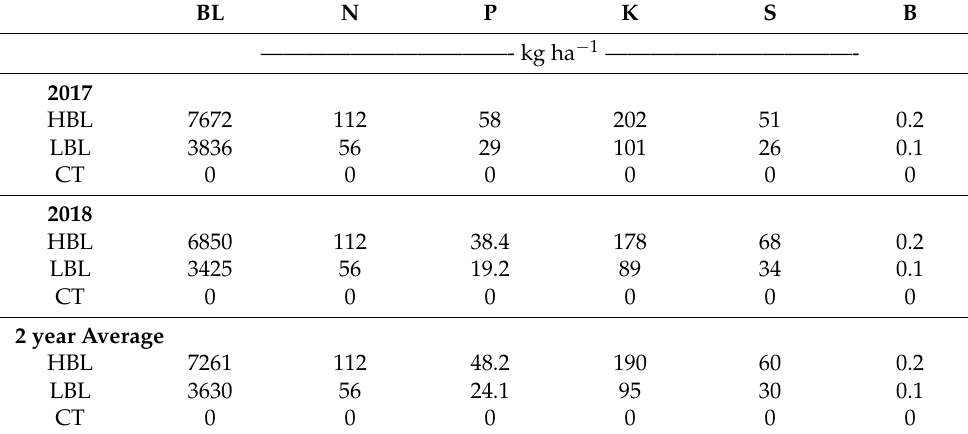
Table 2. Mean amounts of broiler litter (BL) and BL nutrients added to high-level BL (HBL), low-level BL (LBL), and control treatment (CT) treatment plots during 2017 and